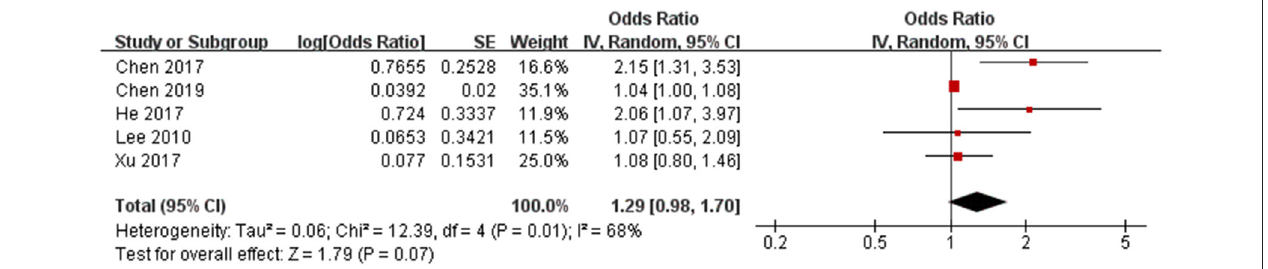
Frontiers in Pediatrics |